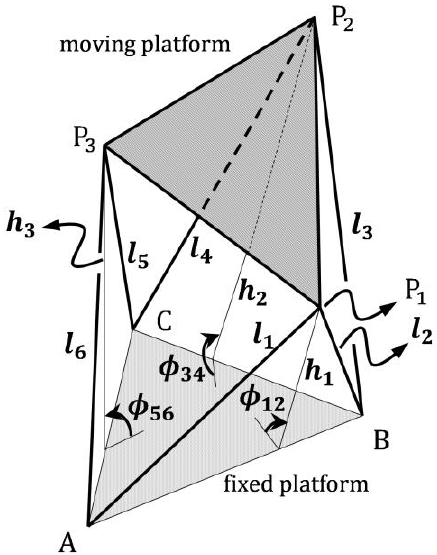
Figure 1. General view of the 3-3 Stewart platform.